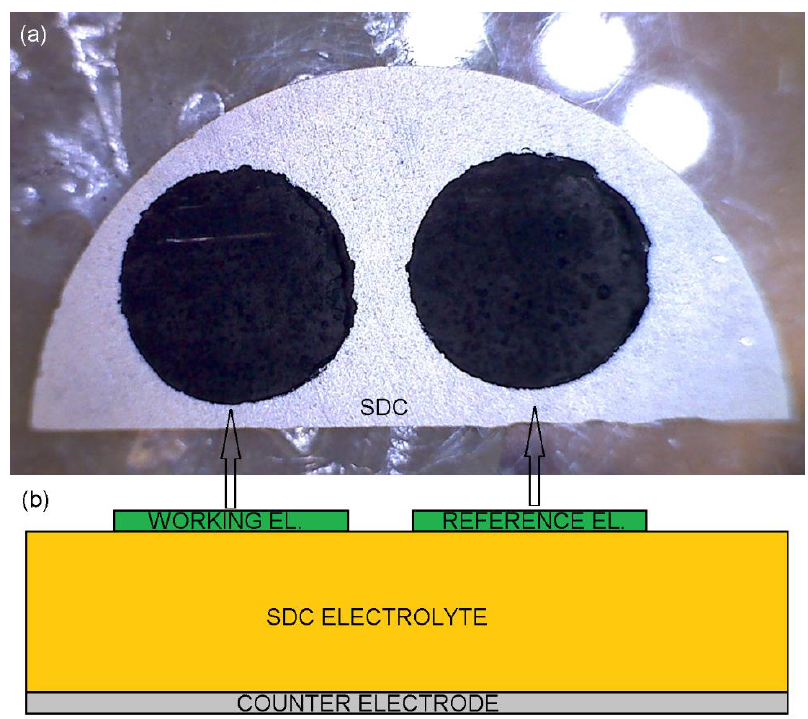
Figure 1. The sintered cell ( a ) top view photography and ( b ) side-view